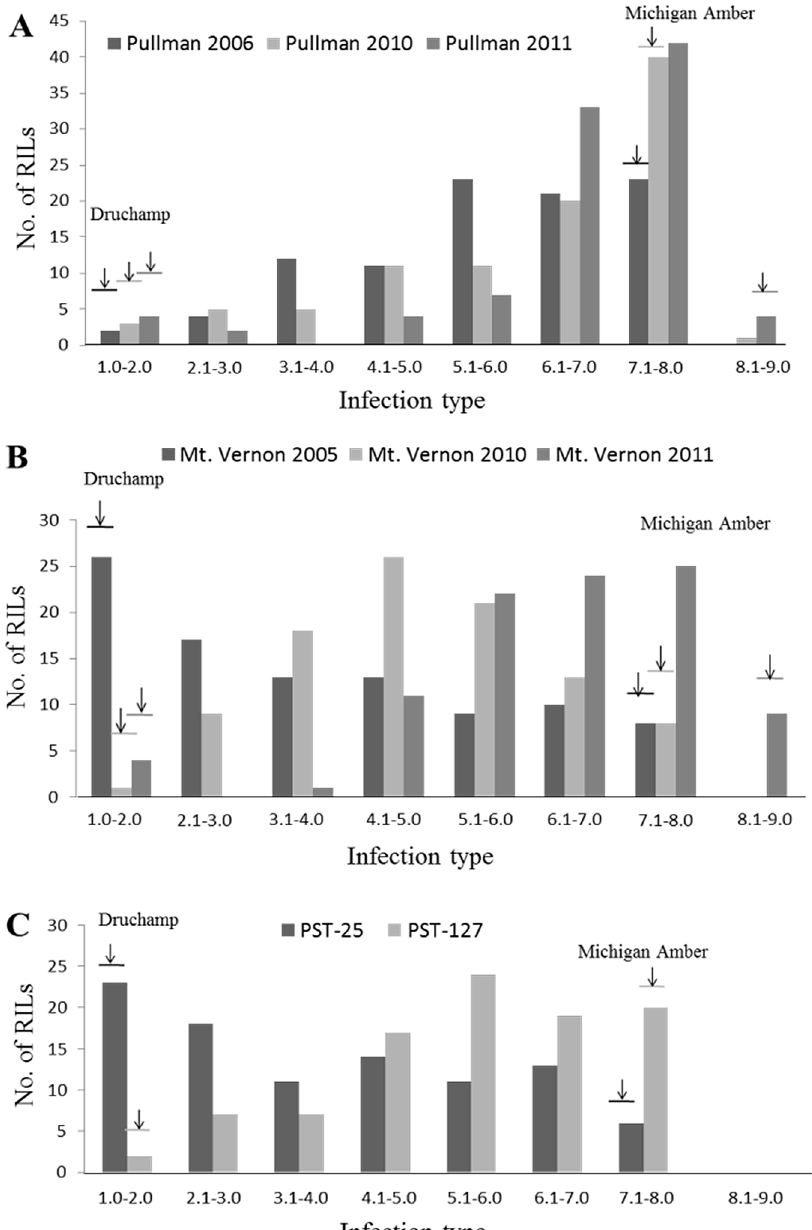
Fig 1. Frequency distributions of mean infection type (IT) values in the Druchamp × Michigan Amber derived recombinant inbred line (RIL) population tested with Puccinia striiformis f. sp. tritici in various environments. IT distribution of: ( A ) Pullman, WA in 2006, 2010 and 2011; ( B ) Mt. Vernon, WA in 2005, 2010 and 2011; and ( C ) greenhouse with races PST-25 and